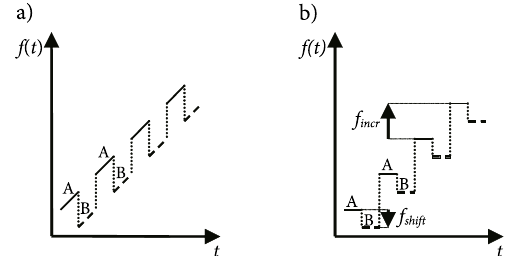
Fig. 1. The LFM-FSK modulating signal: a) strictly linear b) stepwise